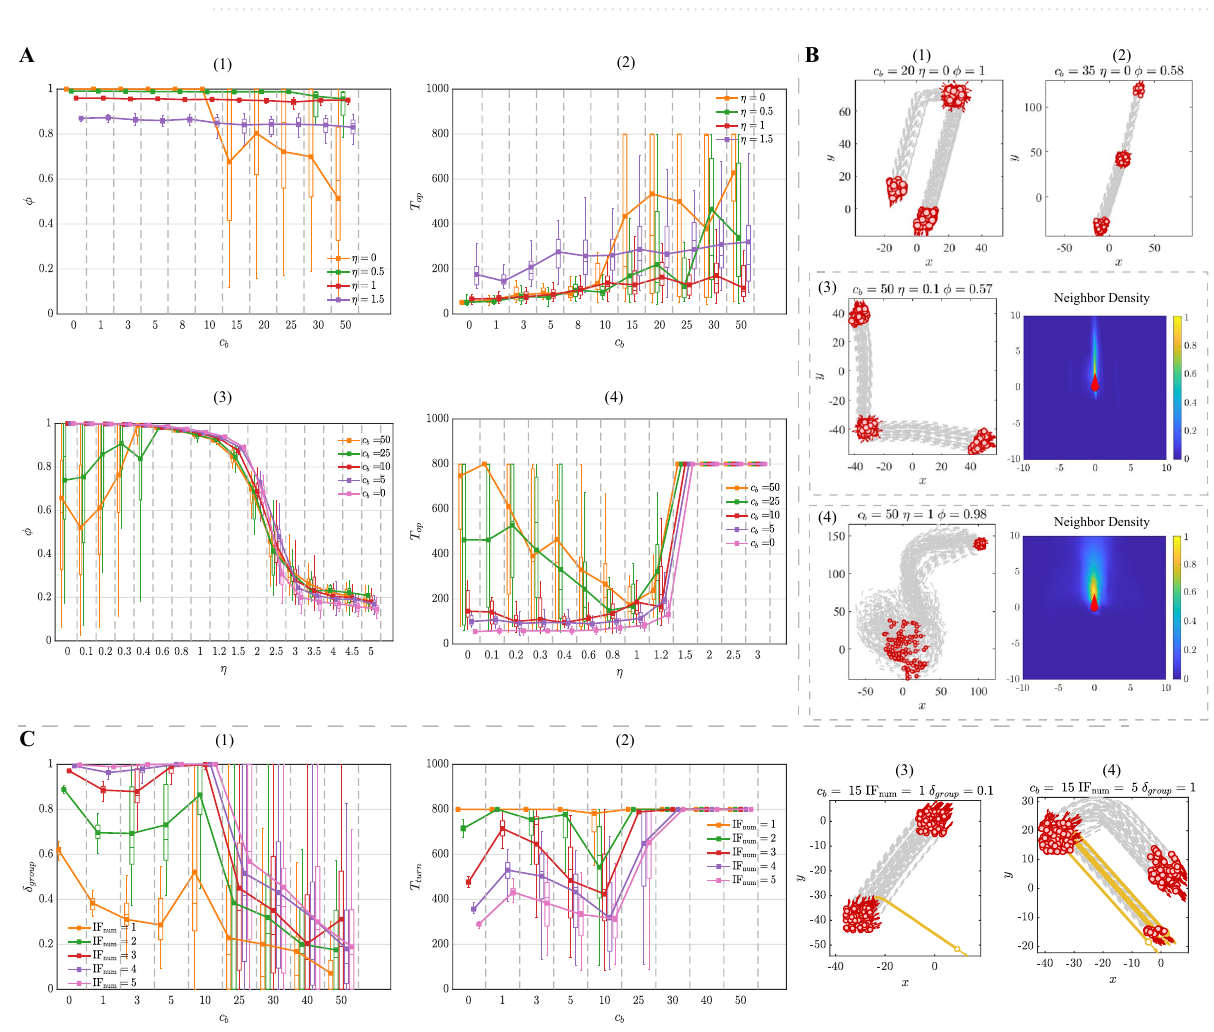
Figure 4. ( A ) The property of flocking as the evolution of c b and η in the BEAR-S model. ( A -(1)) The polarization φ as a function of c b . ( A -(2)) The convergence time T op as a function of c b . ( A -(3)) The polarization φ as a function of noise η . ( A -(4)) The convergence time T op as a function of noise η . ( B ) The trajectories of flocking with different c b . ( C ) The property of responsivity to stimulus with the evolution of c b in the BEAR-S model. ( C -(1)) The response accuracy δ group as a function of c b . ( C -(2)) The response time T turn as a function of c b . ( C -(3–4)) The trajectories of response to stimulus with different c b . T op = 800 or T turn = 800 indicate that the group is unable to finish the corresponding case within the total simulation time. Each data point represents the average of 50 simulation runs with the boxplot. Boxplots in the block divided by the dotted line belong to the same data point but are shifted at different positions on the x-axis to be more